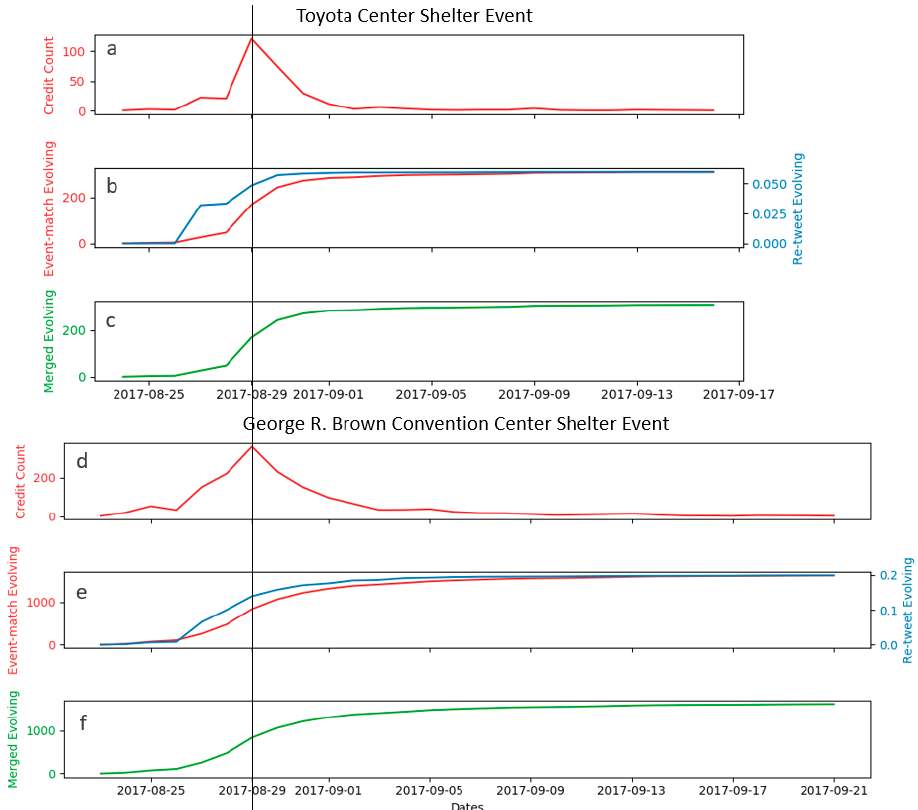
Figure 8. Evolving credibility of two event examples (Toyota Center (Panels a , b , and c ) and George Brown Convention Center (Panels d , e , and f )). Panels a and d are credit counts, panels b and e are event-match evolving, and panels c and f are merged evolving.